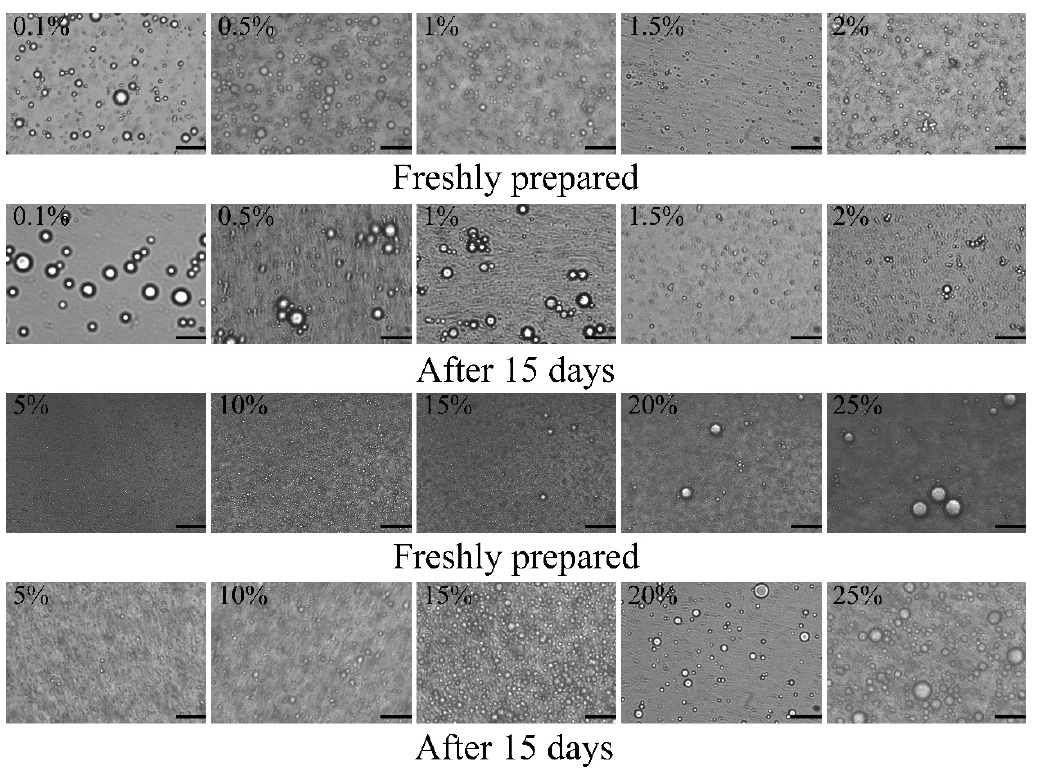
Figure 4. Optical microscopic images of Pickering emulsions stabilized by Z-R/P 2:1 particles with different concentrations (0.1 wt% ‒ 2 wt%) at a fixed oil phase fraction of 5% and different oil phase volume fractions (5% ‒ 25%, v / v ) at a fixed Z-R/P 2:1 particle concentration of 1.5 wt%. The scale bar is 2 μ m.